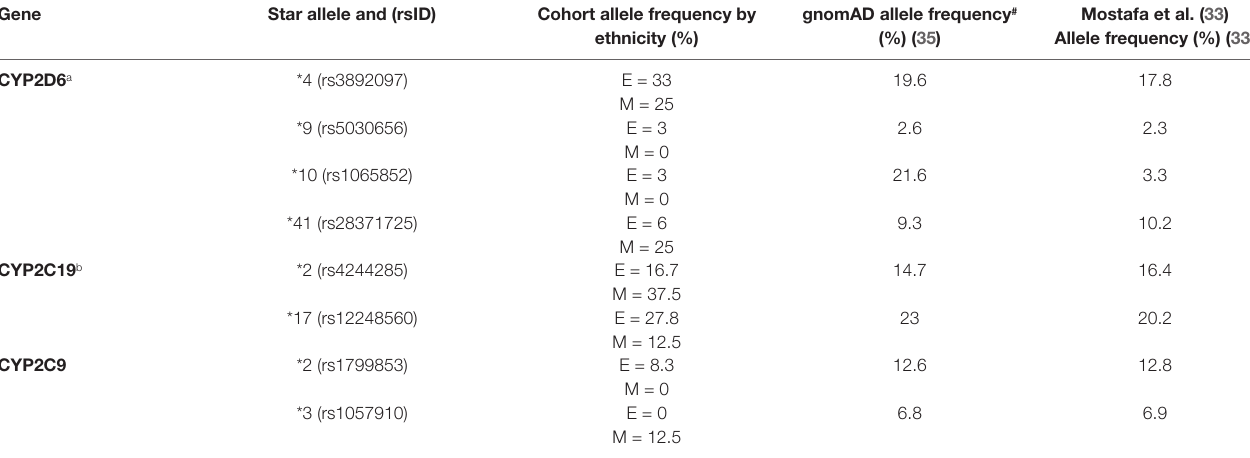
TABLE 3 | Genotyping information for 22 study participants, broken down by ethnicity [E = European (n = 18), M = M ā ori (n = 4)]. Gene Star allele and